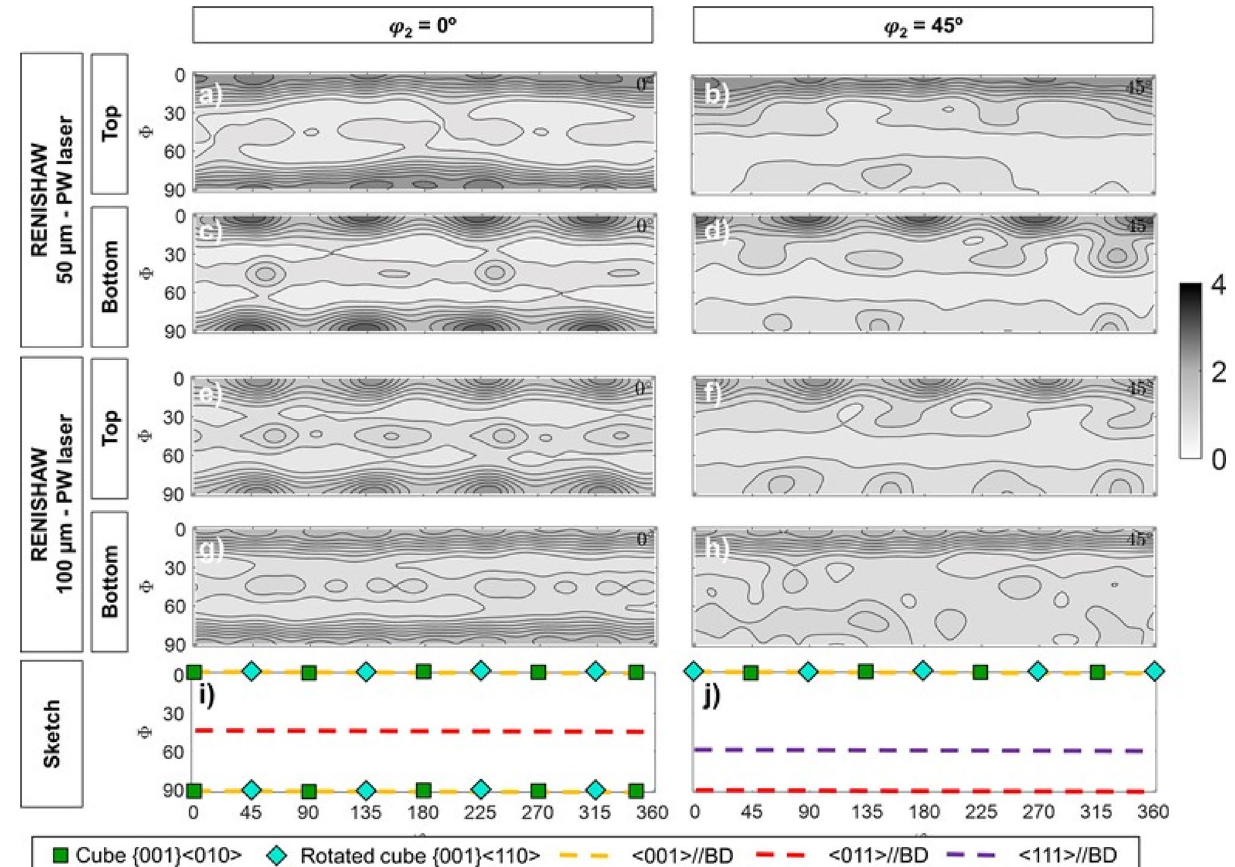
Figure 3. ( a , c , e , g , i ) ϕ 2 = 0° and ( b , d , f , h , j ) ϕ 2 = 45° ODF sections corresponding to the martensitic matrix